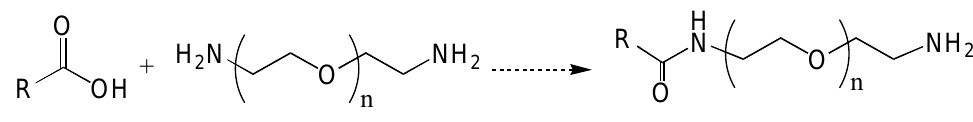
Figure 19. Lipase-catalyzed amidation of PEG.